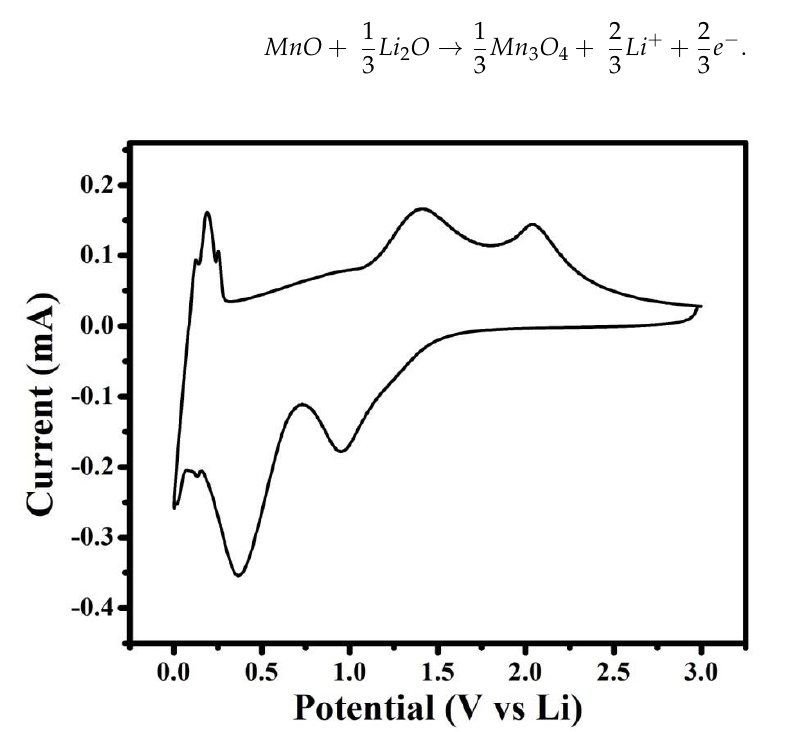
Figure 5. Cyclic voltammetry curve of the NMO electrode at scan rate of 0.1 mV/s.